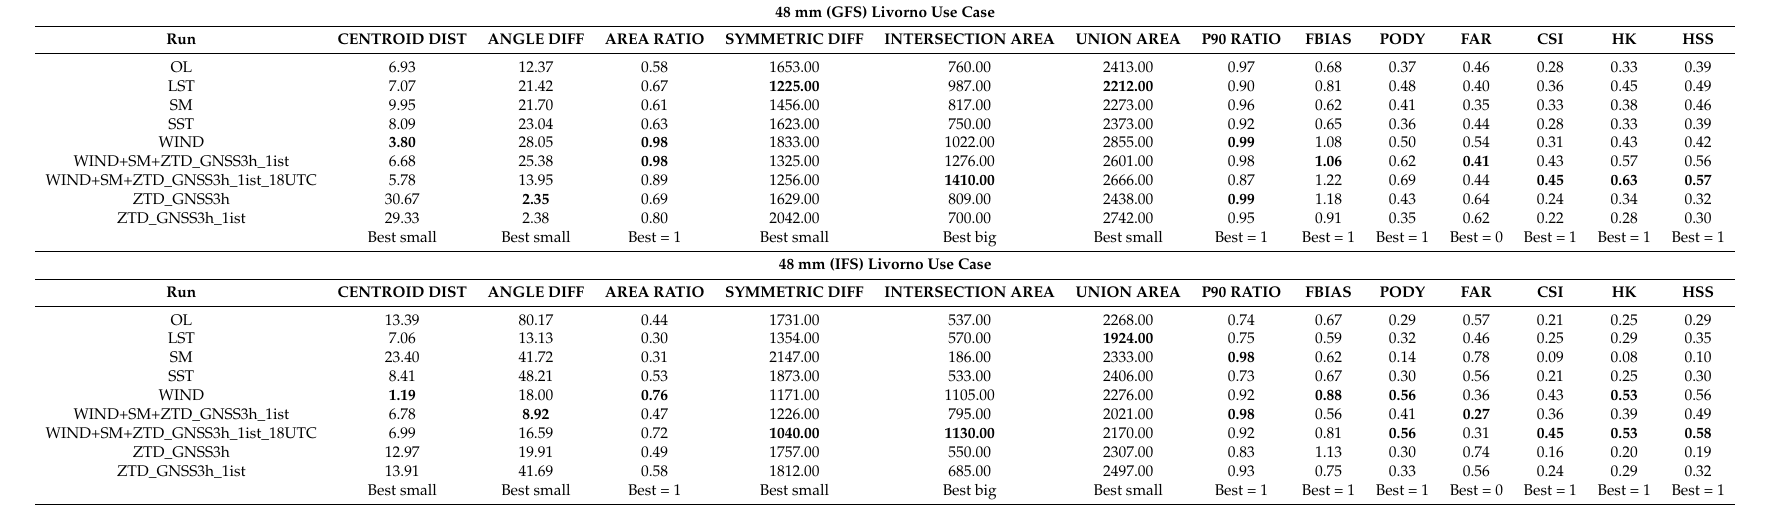
Table A3. Spatial and statistical indices calculated through MODE (48 mm rainfall depth threshold) to evaluate the sensitivity forecasts (driven by GFS and IFS respectively) with respect to the Open Loop run for the time interval 18UTC 09/09/2017–06UTC 10/09/2017. The best performance for each score is highlighted in